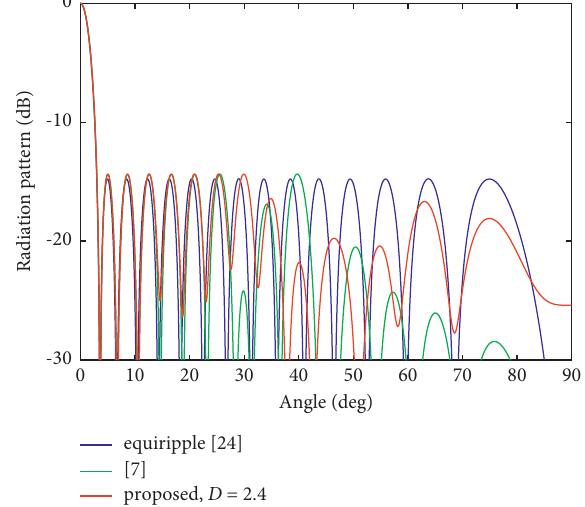
Figure 8: Radiation patterns of proposed pencil beam array, array having equiripple sidelobes and unconstrained DRR [24], and array having minimum DRR for given SLL and all positive coefcients [7]. All arrays have 30 elements and beamwidth of 6 ° .